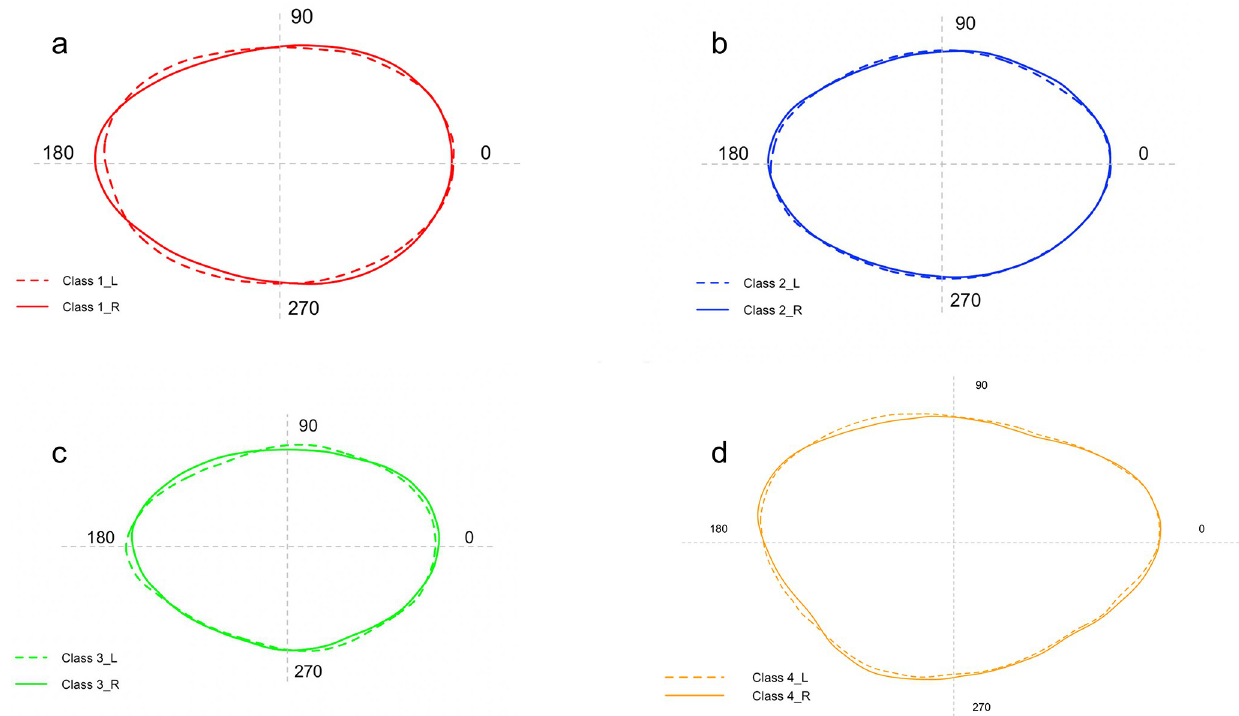
Fig 8. Comparison between the mean shape of left and right lapilli contours belonging to Class I (a), Class II (b), Class III (c) and Class (IV).